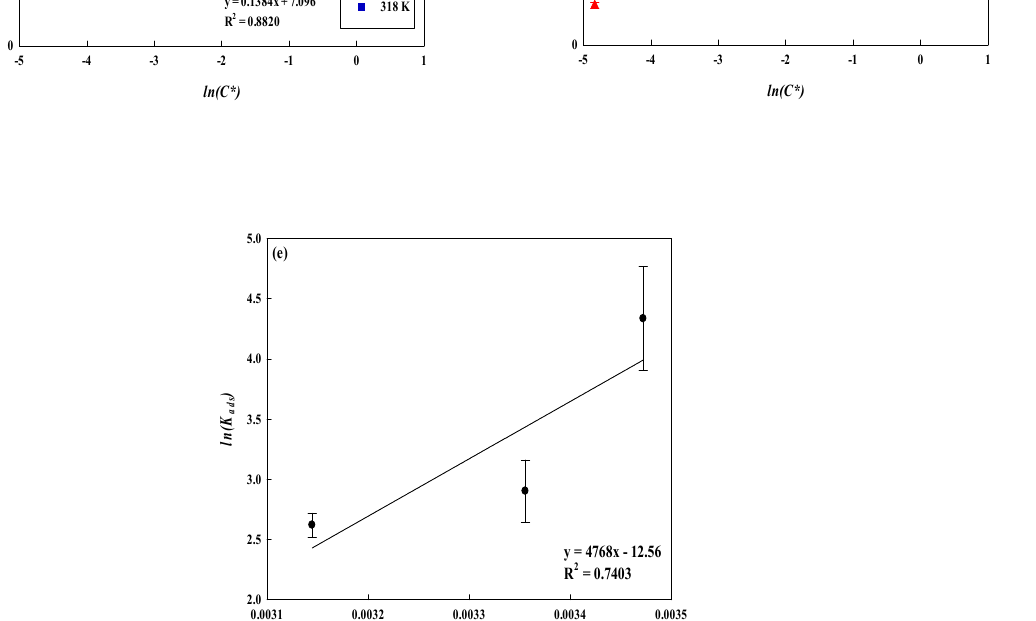
0.8729 Table 5. The thermodynamic parameters for the adsorption of lysozyme onto the P-COOH-CS-RG19 nanofiber membrane at different temperatures. Temperature